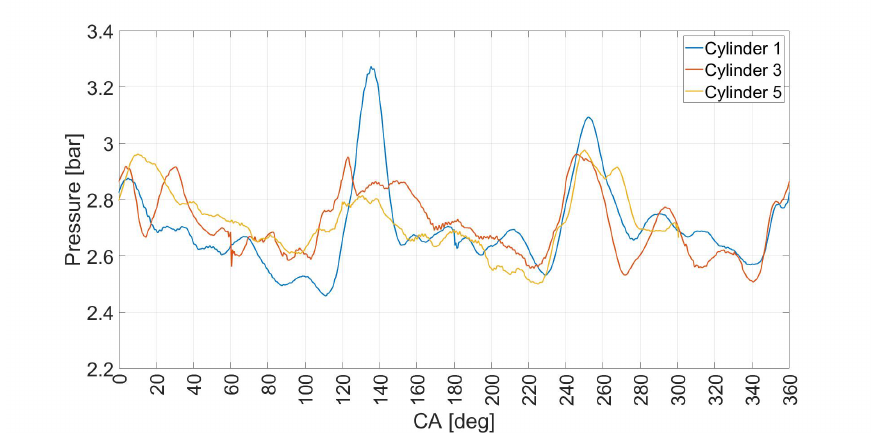
Figure 13. Experimental pressure profiles at the exhaust sections for the three cylinders as a function of CAD. 0 ◦ refers to the TDC of Cylinder